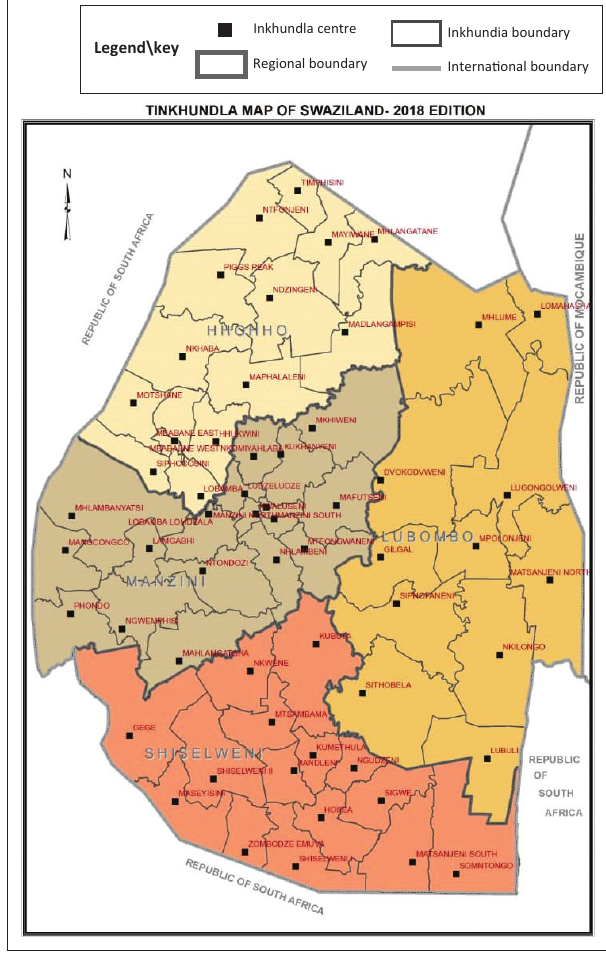
FIGURE 1: Map of